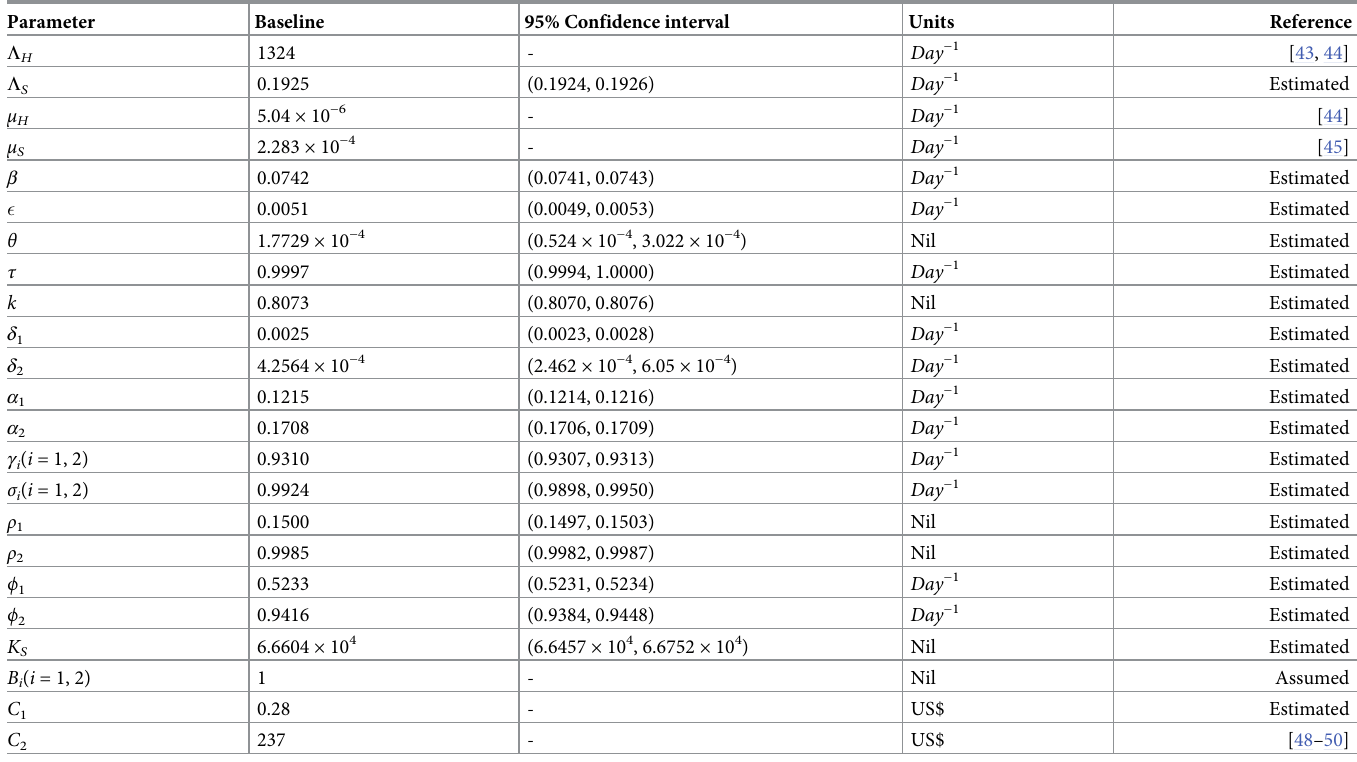
Table 5. Estimated values of the model